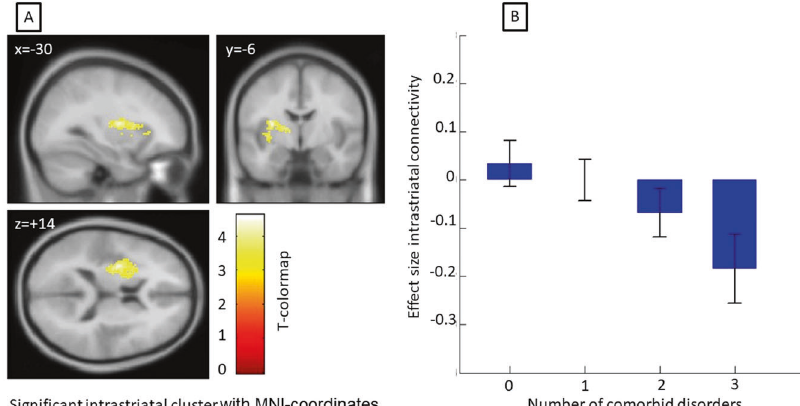
Fig. 3 Change of accumbens seed connectivity in dependence of number of comorbidities. A The intrastriatal cluster in the left striatum which signi fi cantly demonstrated less connectivity to the accumbens dependent on the number of comorbid disorders. The color coding of the cluster is given in the T-colormap. B The decline of connectivity from the intrastriatal cluster to the accumbens in for each number of comorbid disorders. Effect sizes were extracted from the signi fi cant cluster from panel